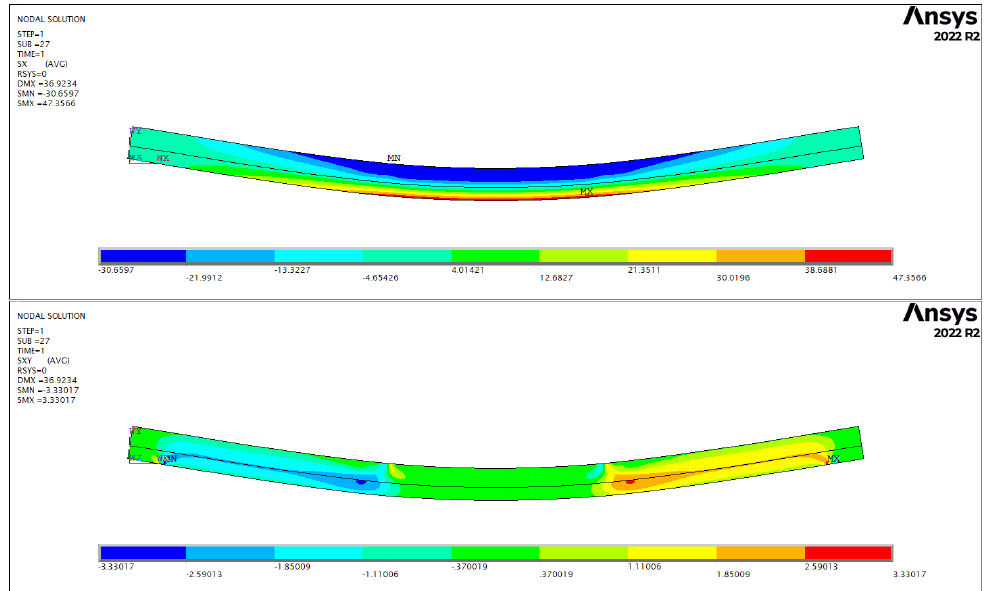
Figure 7. Longitudinal normal stress ( top ) and shear stress ( bottom ) distributions for specimen F-6.